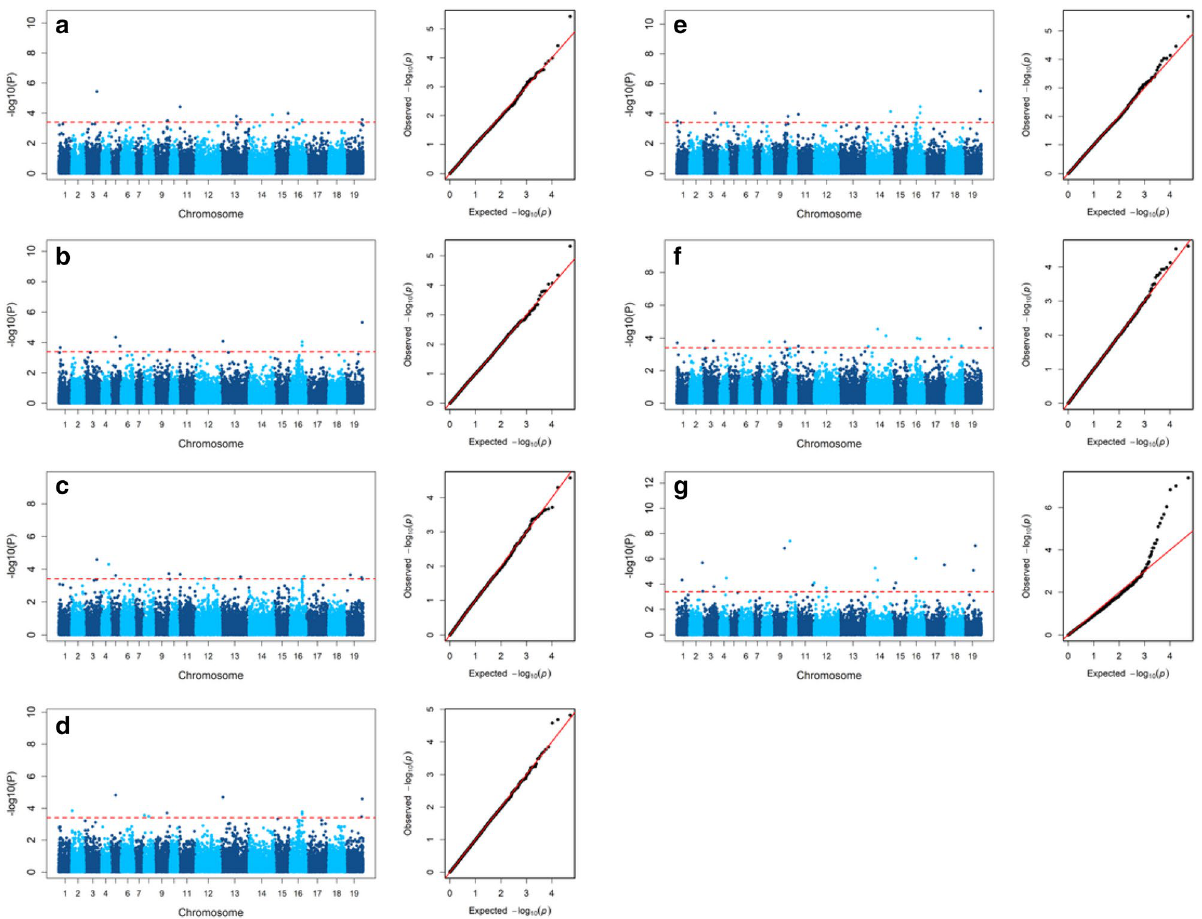
Figure 5. Manhattan and Q–Q plots showing the results of marker-trait association for sclerotinia stem rot resistance in 187 rapeseed/canola genotypes by the fixed and random model circulating probability unification (FarmCPU) GWAS model. ( a ) Lesion length, Carrington 2019; ( b ) lesion length, Langdon, 2019; ( c ) lesion length, Carrington 2020; ( d ) lesion length, Osnabrock 2020; ( e ) lesion length, combined data (CombENV); ( f ) plant mortality_14D, combined data (CombENV); and ( g ) plant mortality_21D, combined data (CombENV). The − log 10 ( P ) values from a genome-wide scan are plotted against positions on each of the 19 chromosomes. Discontinued horizontal lines indicate the genome-wide significance